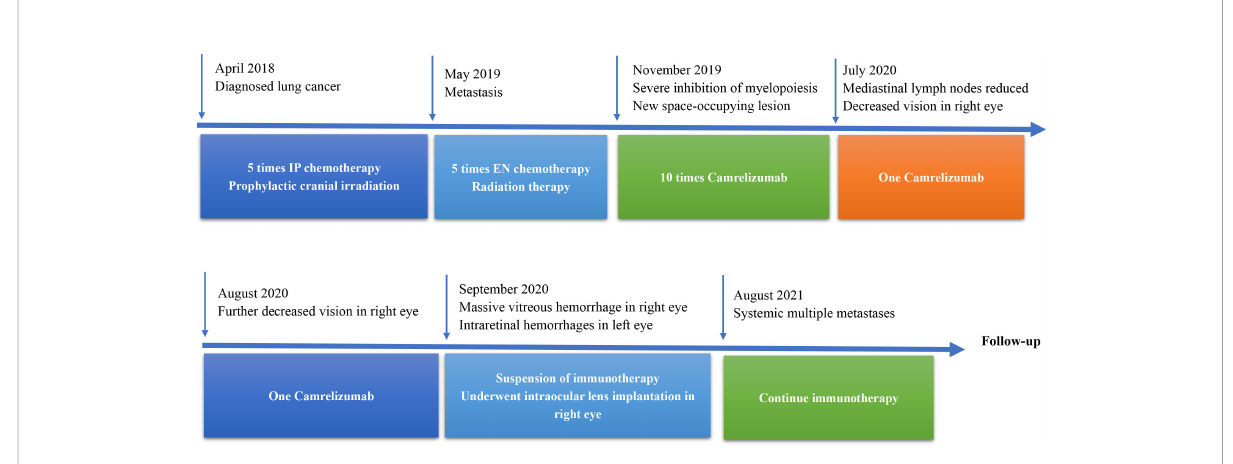
FIGURE 4 Timeline therapy administration from the episode of care. IP, irinotecan cis-platinum; EN, irinotecan, nedaplatin.